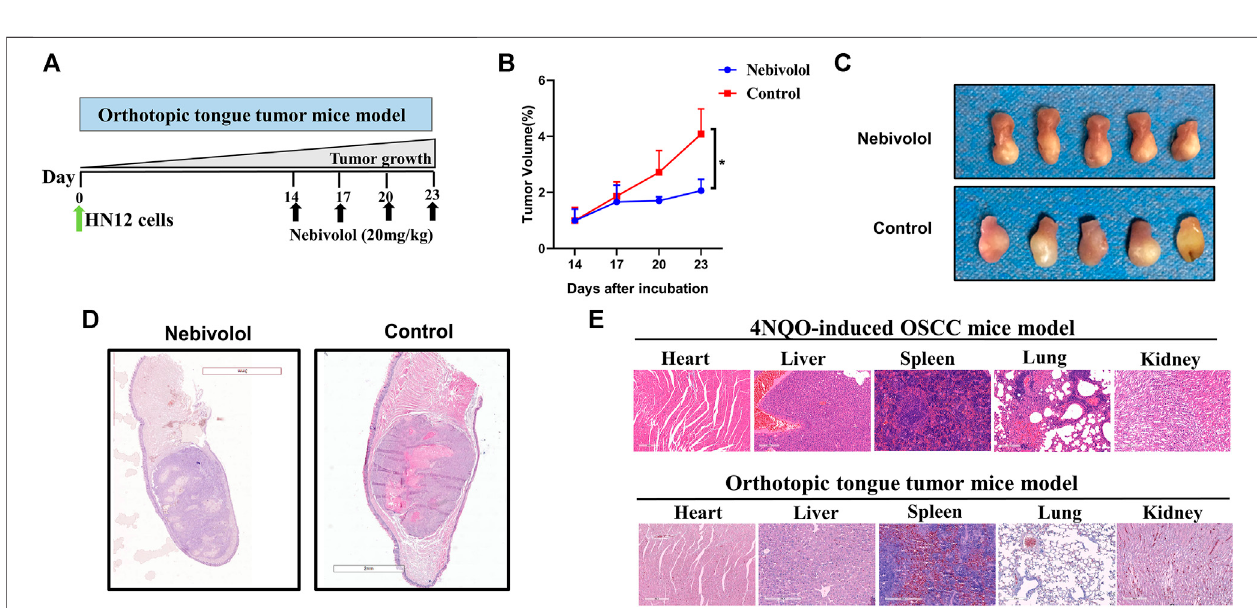
FIGURE2| Nebivololhaltedcancergrowthinorthotopictonguemiceandchemicallyinducedtonguemice. (A) Thepatternoforthotopictonguetumormicemodel. (B) Tumor volume wasdetermined at the indicated time point and the growth curvesfrom twogroups ofmice during 3 weeks were made in the xenografttumor model. (C) Representative images of isolated xenograft tumors treated with vehicle or nebivolol for 3 weeks. (D) Representative HE staining image of isolated xenograft tumors afterbeingtreatedwithvehicleornebivololfor3 weeks. (E) HEstainedimagesofliver,heart,spleen,lung,andkidneyintumortissuesofthecontrolgroupsandthe nebivolol-treated groups from two mice models. Data represent the mean ± SD of three replicate independent experiments. The asterisk (*) indicates a signi fi cant difference compared to the control group (* p < 0.05).